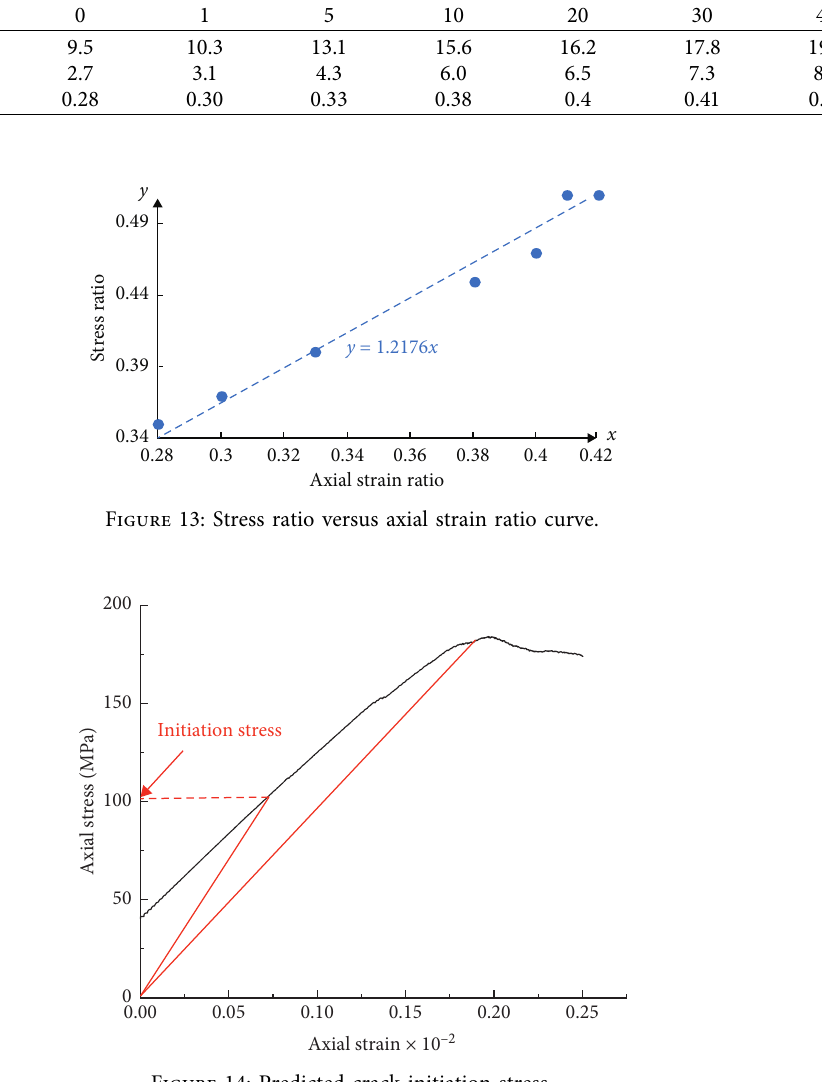
Table 5: Values of ε